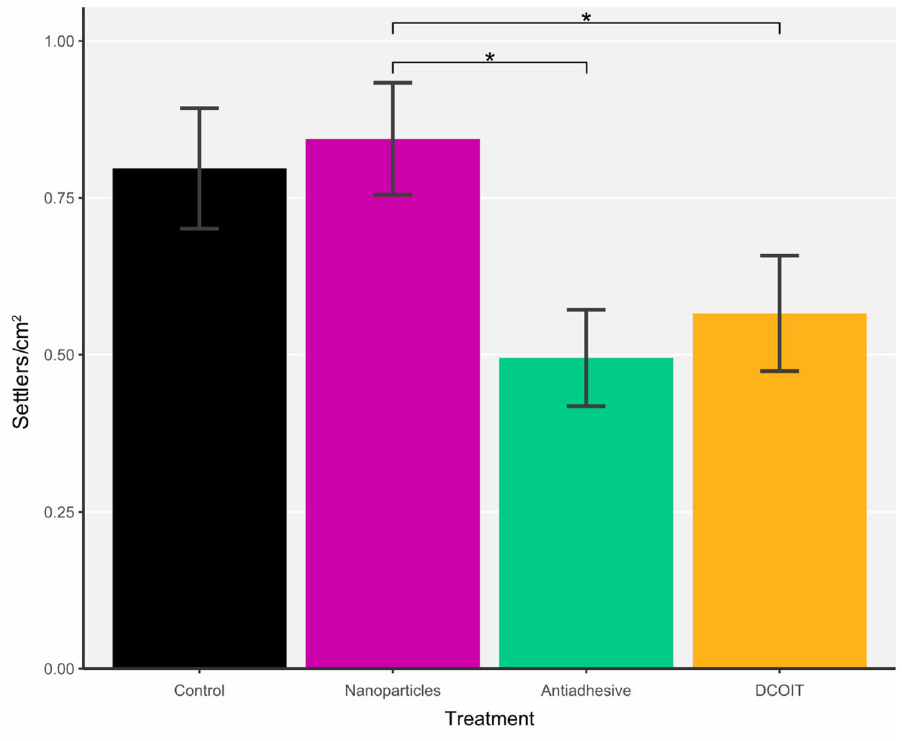
Figure 4. Pre-conditioned fully-coated (FC) plugs (Nanoparticles, Antiadhesive, DCOIT) and uncoated Control plugs (n = 30 plugs per treatment) were tested for mean coral larval settlement (settlers per cm 2 ) in individual glass jars (one plug with 15 larvae per jar). Error bars represent SEM. Asterisks indicate statistically significant differences based on pairwise post-hoc tests with least-squares means (Supplementary Tables S9 and S11; *p <